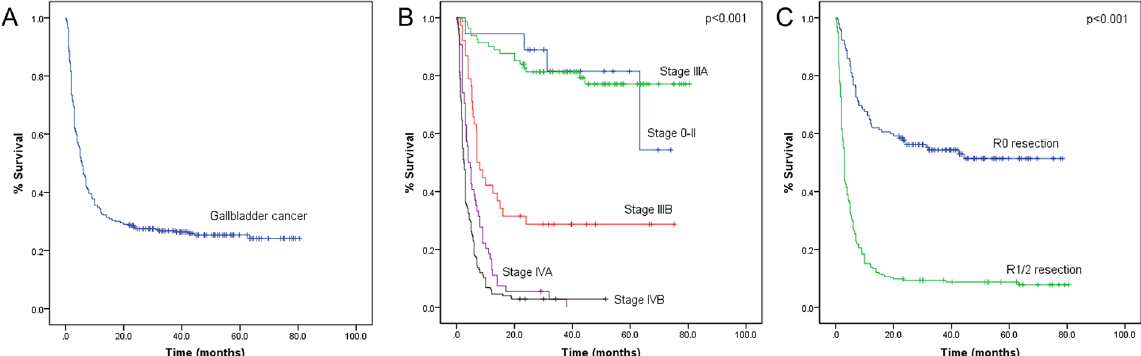
Figure 1. ( A ) Overall survival of GBC patients after surgery. ( B ) Survival of GBC patients with different TNM stage. ( C ) Comparison of patient survival in GBC patients after radical resection or palliative